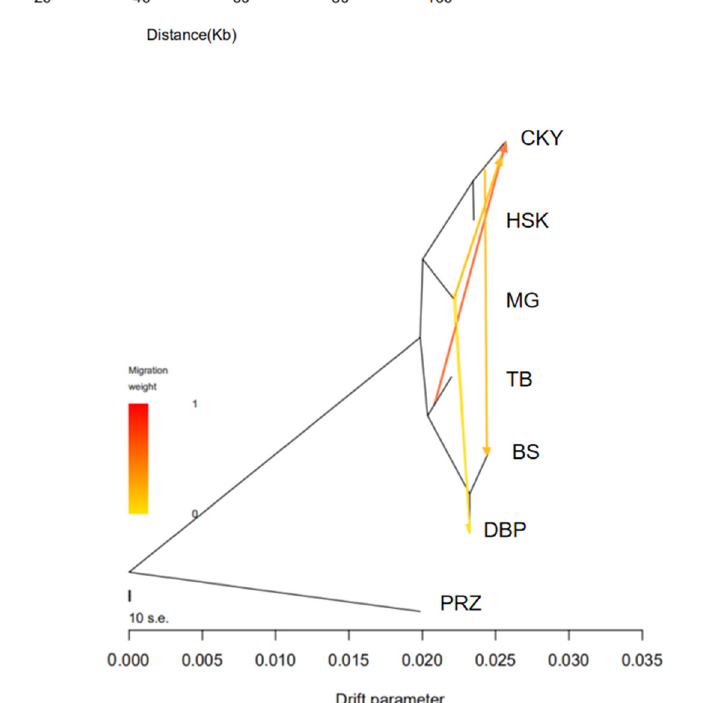
Figure 3. Linkage disequilibrium decay and migration detection of the studied CHBs. ( A ) Linkage disequilibrium decay of the studied CHBs. The studied populations are indicated with different colors. ( B ) Modeling the number of modeled migration events. More migration edges did not further increase the variance explained by the phylogenetic model, as the f index reached an asymptote above 4 migration edges, so m = 4 was chosen as optimum migration mode in the dataset. ( C ) Migrations detected among the studied CHBs by the TreeMix program with four migration events. CKY, Chakouyi horse; HSK, Kazak horse; MG, Mongolian horse; TB, Tibetan horse; BS, Baise horse; DBP, Debao pony; PRZ, Przewalski’s horse.